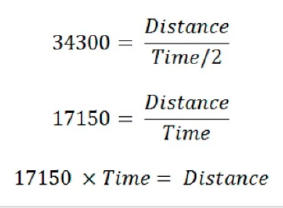
Figure 12. Code Excerpts: controlling motor to open the gate. As for the gate data, which includes gate id, status, water level, and other related data, it is broadcasted through the IoT framework using the update_iot() function, as shown in Figure 13. Figure 13. Code Excerpts: using open-source IoT libraries and services, such as Dweet.io. The gate_id is a unique number assigned to each gate to differentiate it among other gates in the target region. After packaging the gate data in a JSON (JavaScript Object Notation) object, which is a data format understood by all cloud services, browsers, and databases, the data is then published to the cloud through Dweet.io, an open-source IoT service, as discussed in detail in the next section. 3.3. Broadcasting Gate Data In order to allow the stakeholders to remotely monitor the floodgates through the IoT framework, the controller needs to publish its data to the cloud. The process is shown symbolically in Figure 14. As shown in the figure, publishing gate data to the cloud involves the following processes: